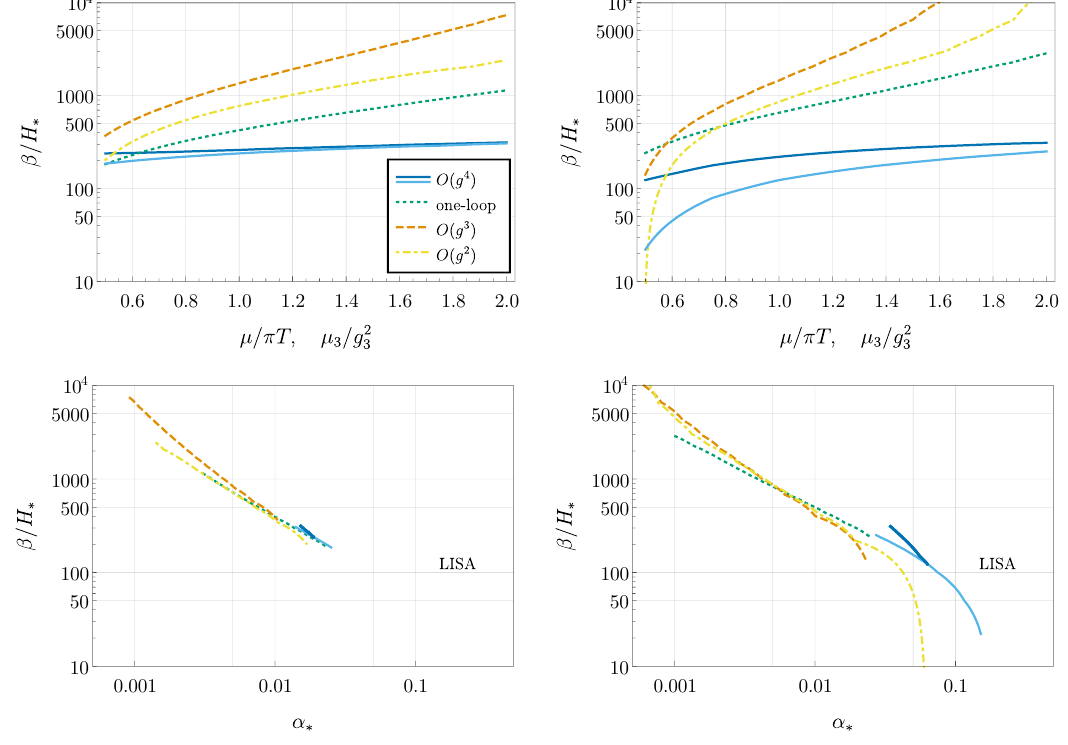
Figure 6. Upper plots are as figure 5 but for β/H ∗ . The lower plots show a revisualisation of the renormalisation scale dependence in the ( α ∗ , β/H ∗ ) -plane. For context, the approximate region to which LISA is sensitive is indicated.